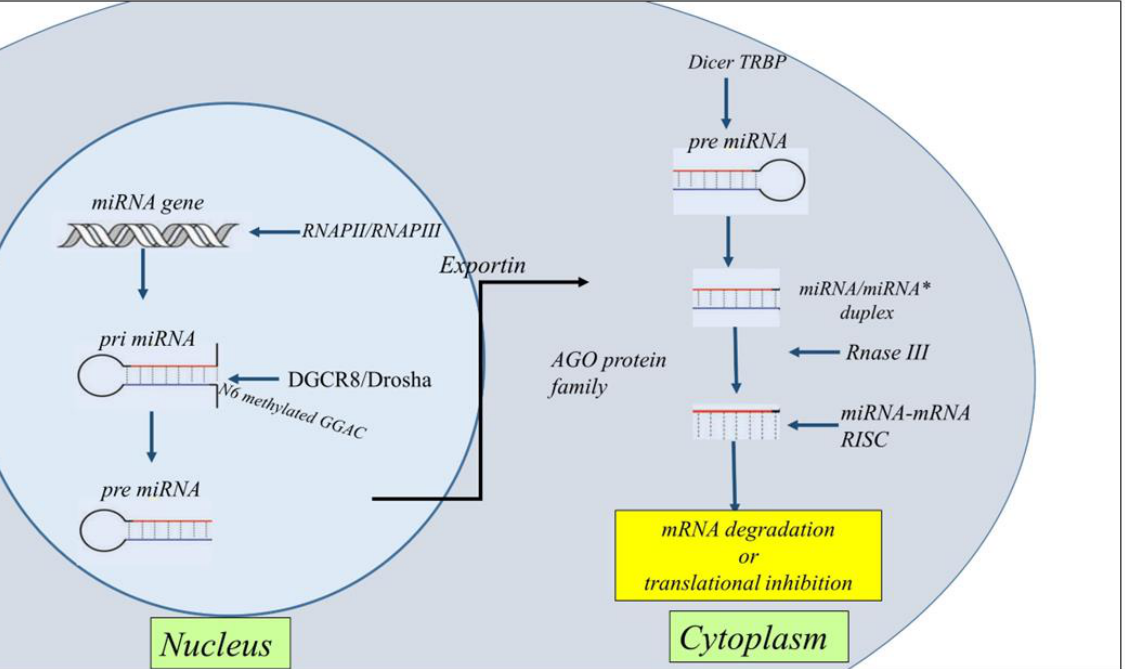
Drosha/DGCR8-independent and Dicer-independent. Drosha/DGCR8-independent path-